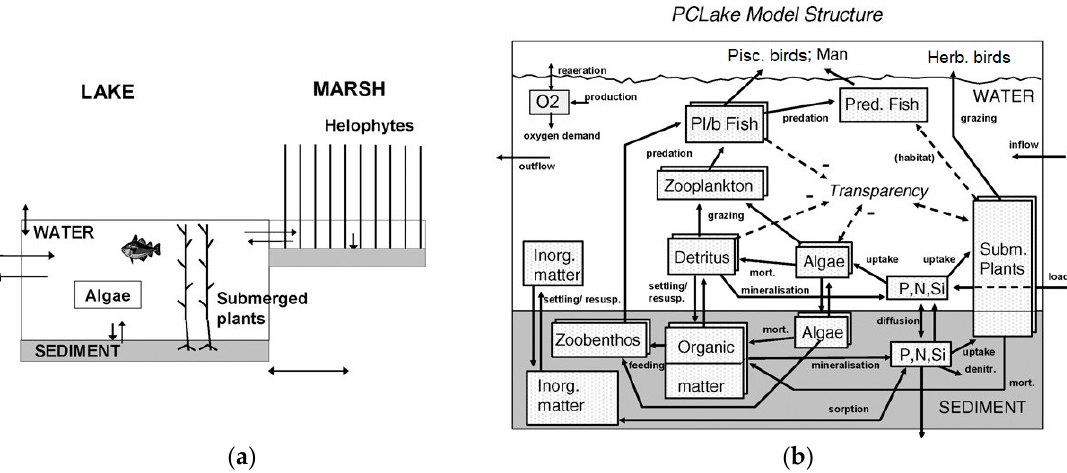
Figure 5. Illustration of the PCLake model. ( a ) Diagram of the lake structure and ( b ) schematic model structure. Solid lines indicate material flow and dashed lines indicate a functional relationship. Negative and positive signs indicate decreased and increased transparency, respectively. The abbreviations are as follows: denitr., denitrification; Herb. birds, herbivorous birds; Inorg. matter, inorganic matter; mort., natural mortality; Pisc. birds, predatory birds; Pl/b Fish, Piscivorous fish and benthivorous fish; Pred. Fish, predatory fish; resusp., resuspension; and Subm. plants, submerged plants. Modified from Janse [23].